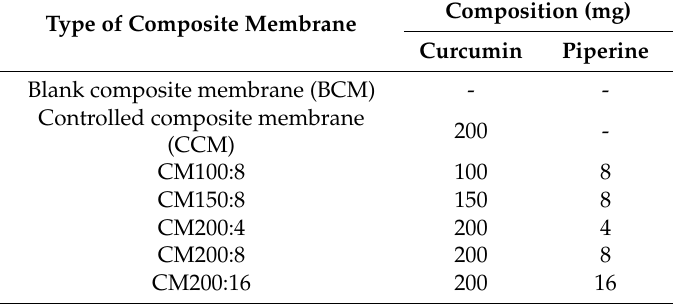
Table 1. Types and compositions of bacterially derived cellulose-composite membranes with a size of 78.57 cm 2